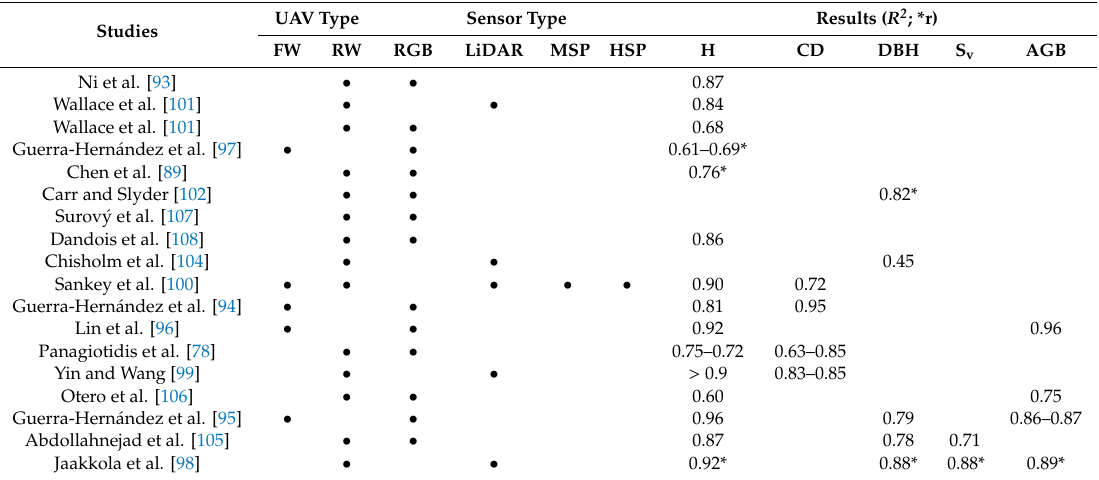
Table 2. Unmanned aerial vehicle type, sensing payloads and results from tree-level studies.